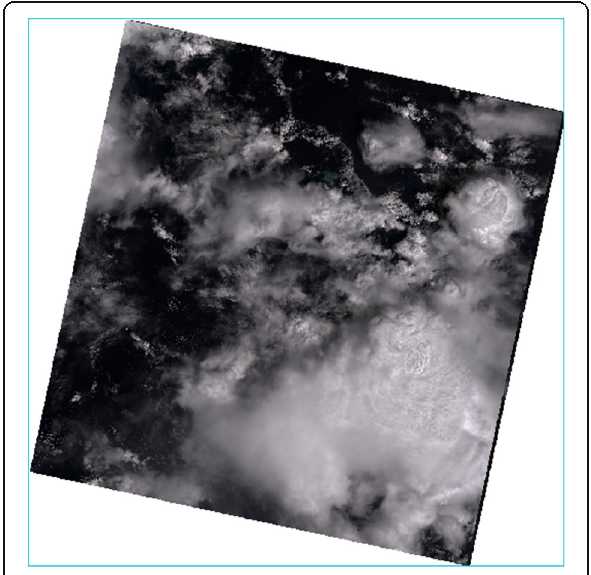
Fig. 4 The moving path of typhoon “ Mujigae ”